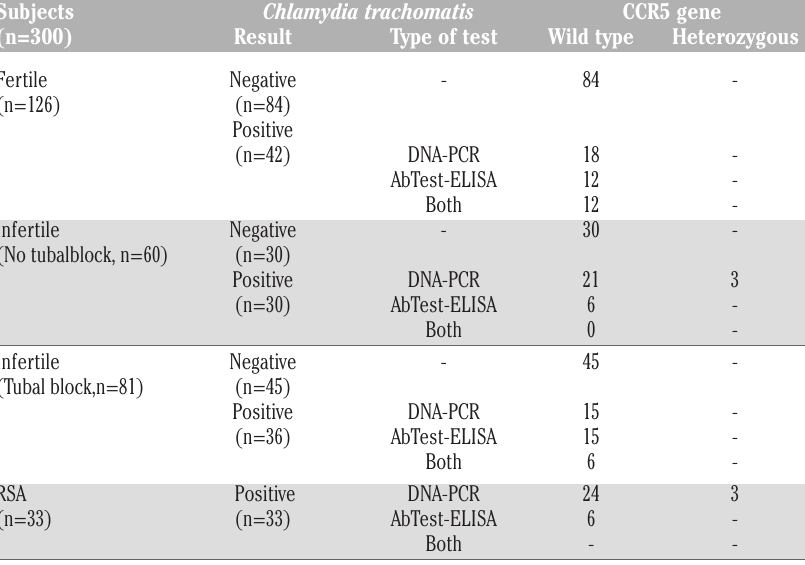
Table 1. Frequency of CCR5 (cid:0) 32 gene deletion in different group of women with or with- out Chlamydia